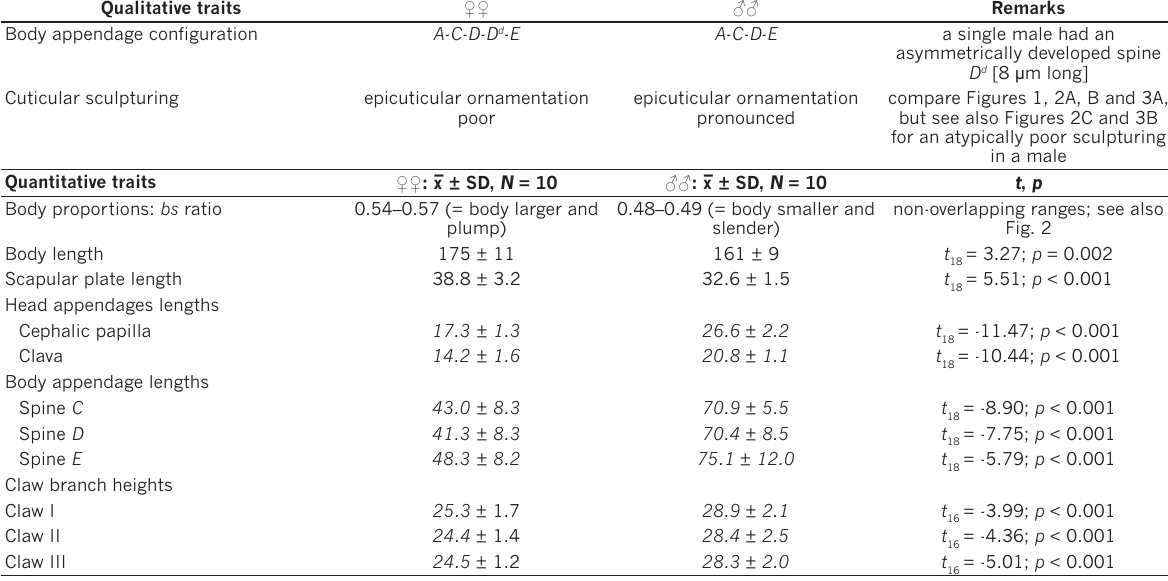
Table 4. Sexual dimorphism in qualitative and quantitative traits in Echiniscus masculinus sp. nov., with results of one-tailed Stu- dent’s t -tests in case of overlapping ranges in morphometric traits (all statistically significant at the α-level of p with the Benjamini-Hochberg